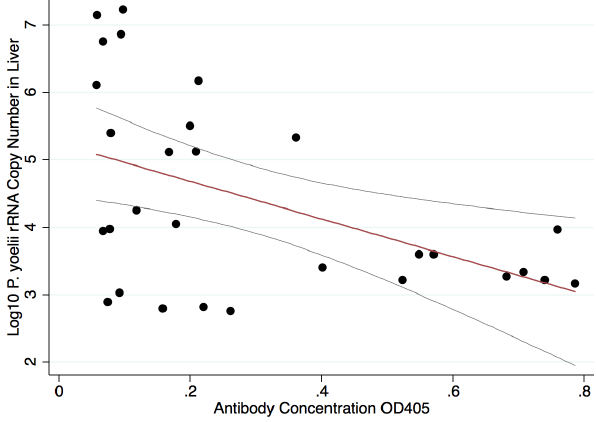
Figure 5. Association between anti-CSP antibody concentra- tion and sporozoite infection of liver. Pearson correlation plot with regression line and 95% CI demonstrating the relationship between anti-CSP antibody concentration within individual mice and the log 10 standardized copy number of P. yoelii rRNA recovered from the liver of the corresponding mouse, (r=0.64, p ,